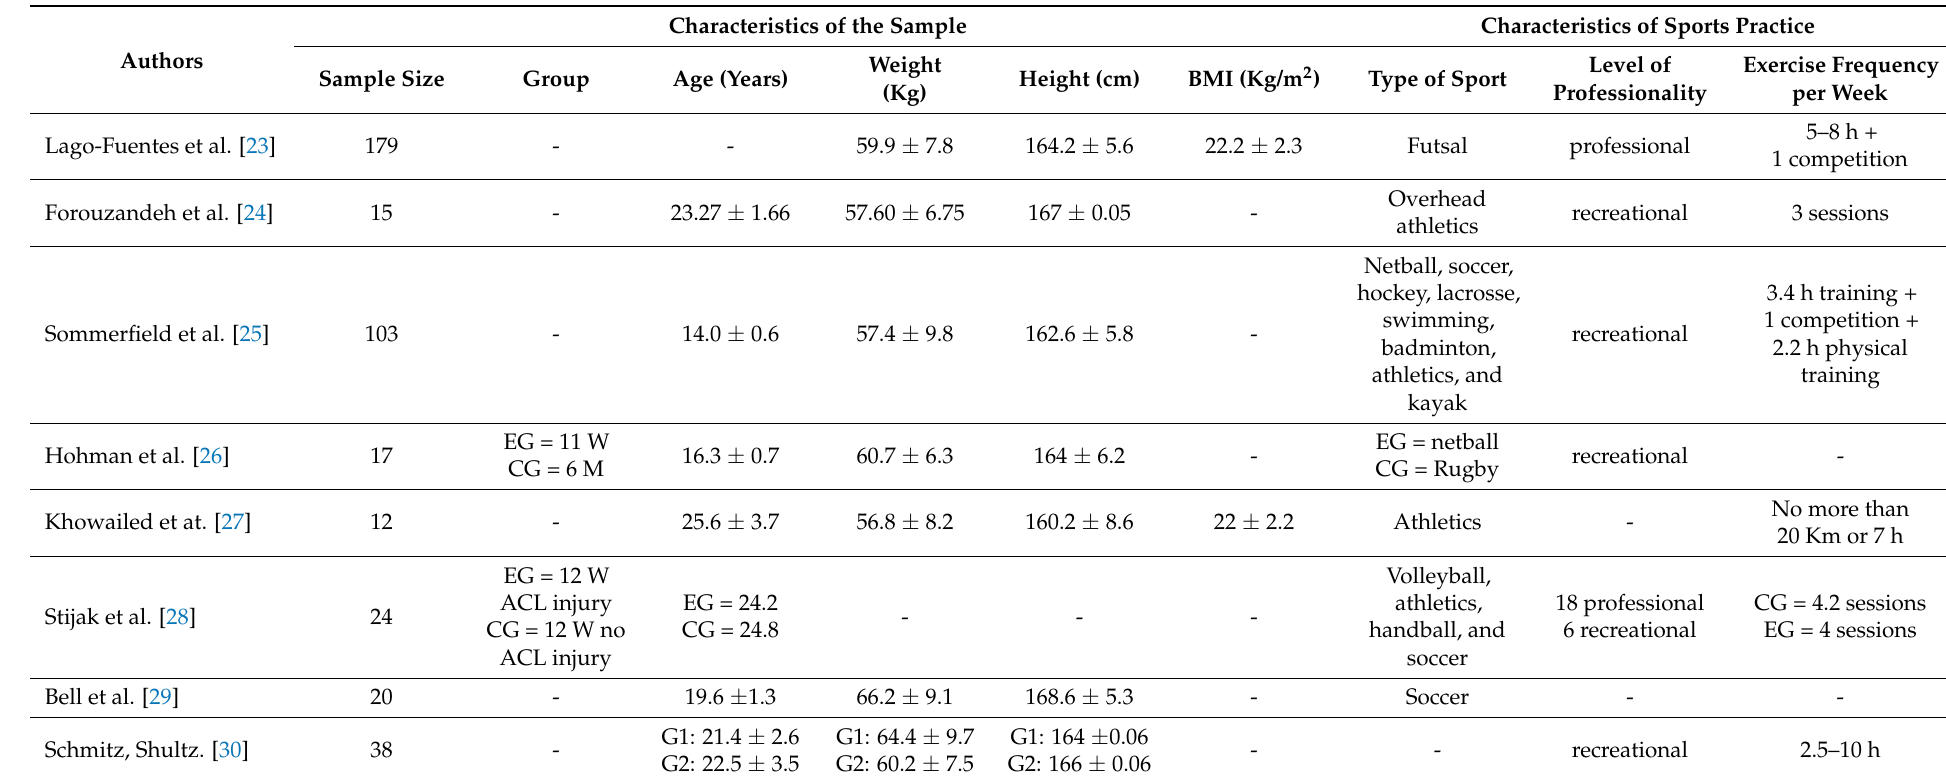
Table 2. Characteristics of the sample, sports practice, and eligibility